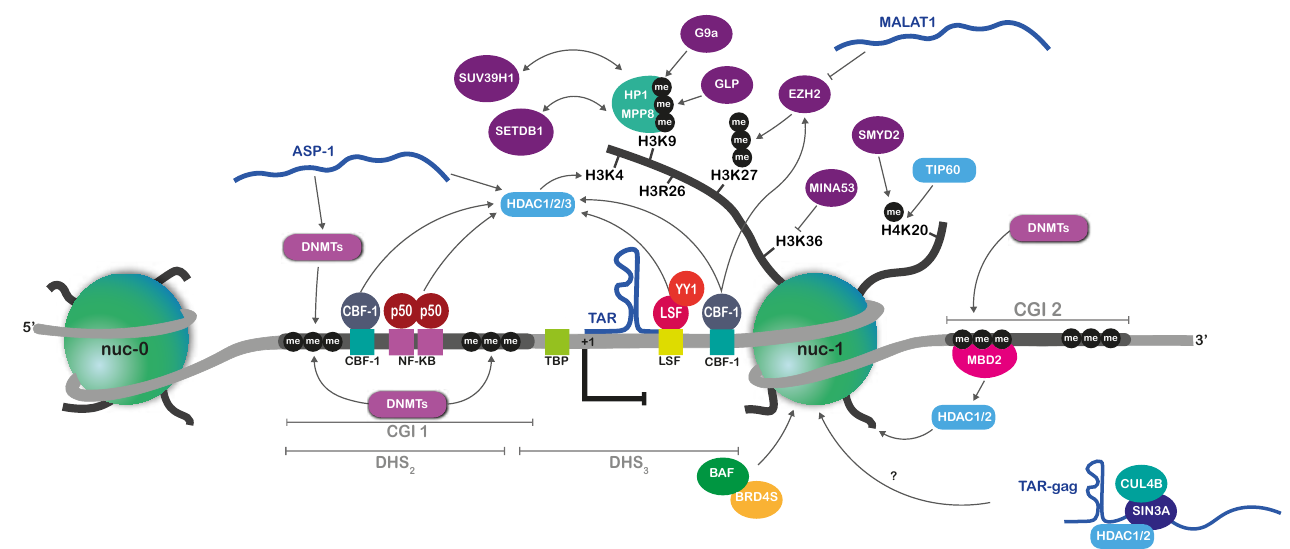
Figure 2. The 5 (cid:48) LTR is heterochromatized in HIV-1 latently infected CD4 + T cells. A multitude of interrelated epigenetic mechanisms cooperatively maintain the HIV-1 promoter in a heterochromatic architecture in latently infected CD4 + T cells. These include the position of repressive nucleosomes on the 5 (cid:48) LTR, the presence of repressive histone marks such as hypoacetylation or H3K9me3, the hypermethylation of two CpG islands surrounding the transcription start site and the involvement of lncRNA-like epigenetic mechanisms.